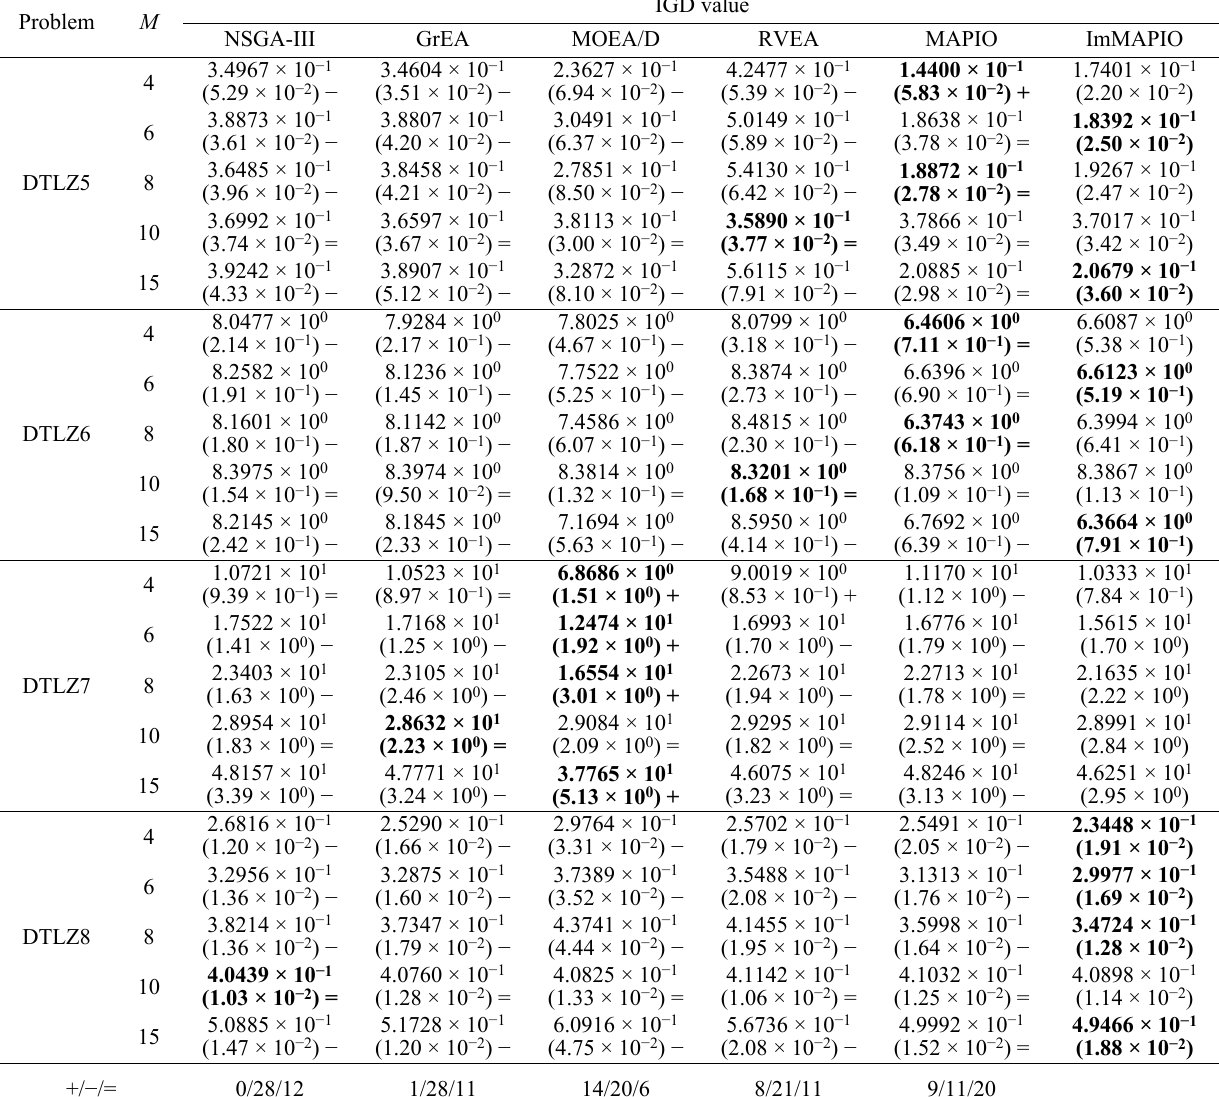
Table 3 IGD values of six algorithms for different objectives in the DTLZ test problems.